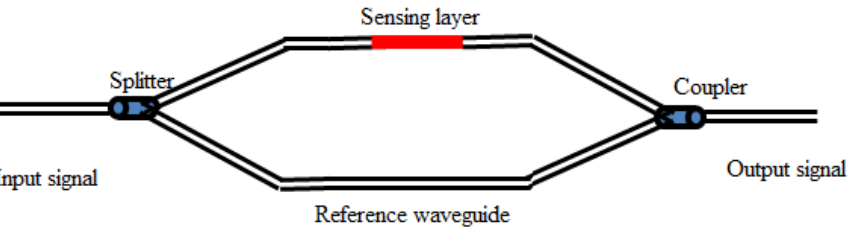
Figure 4. Schematic of Mach-Zehnder